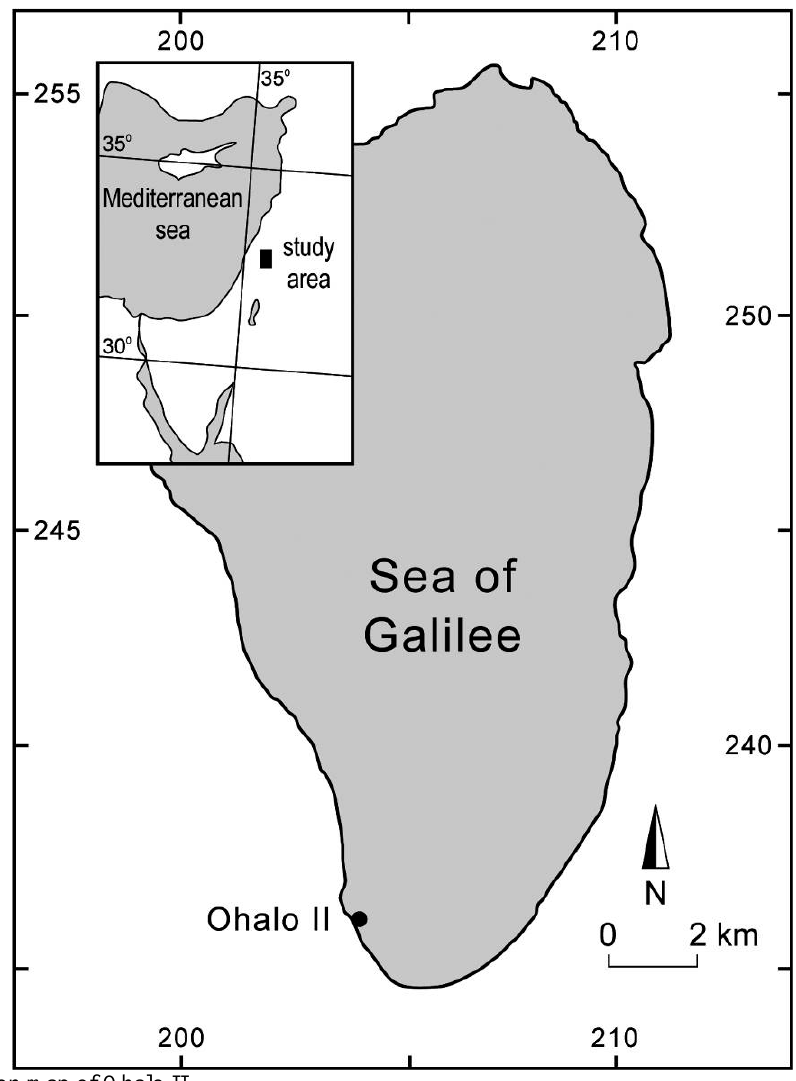
Figure 1. Location map of Ohalo